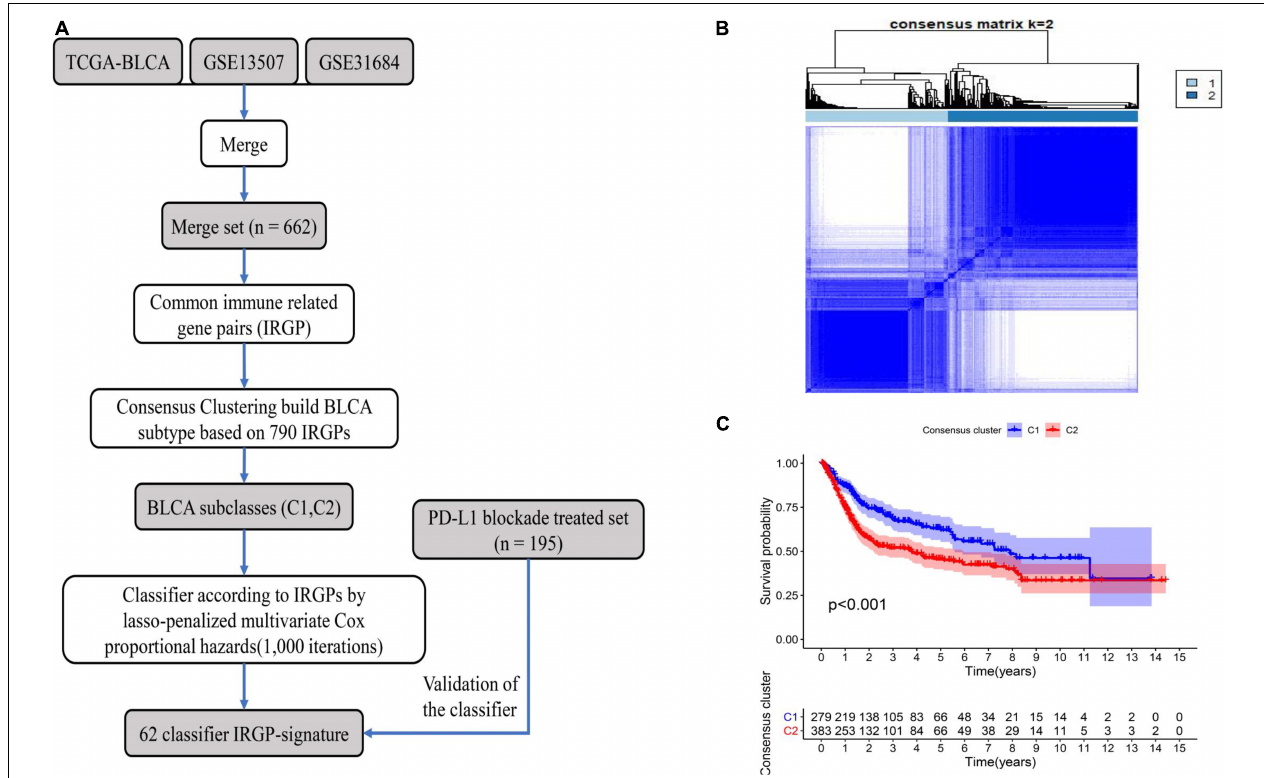
FIGURE 1 | The flowchart describes the construction and validation of our 62 IRGP-signature and consensus clustering of IRGP in BLCA. (A) The flowchart about our work; (B) consensus matrices of BLCA patients for k = 2; (C) differences in patient overall survival with two clusters. IRGP, immune-related gene pair; BLCA, bladder